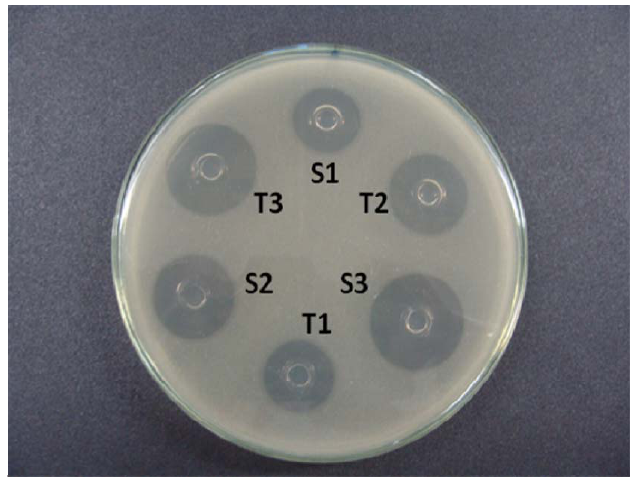
Figure 2. Agar diffusion assay using a strain of B. subitilis ATCC 9371 IAL 1027